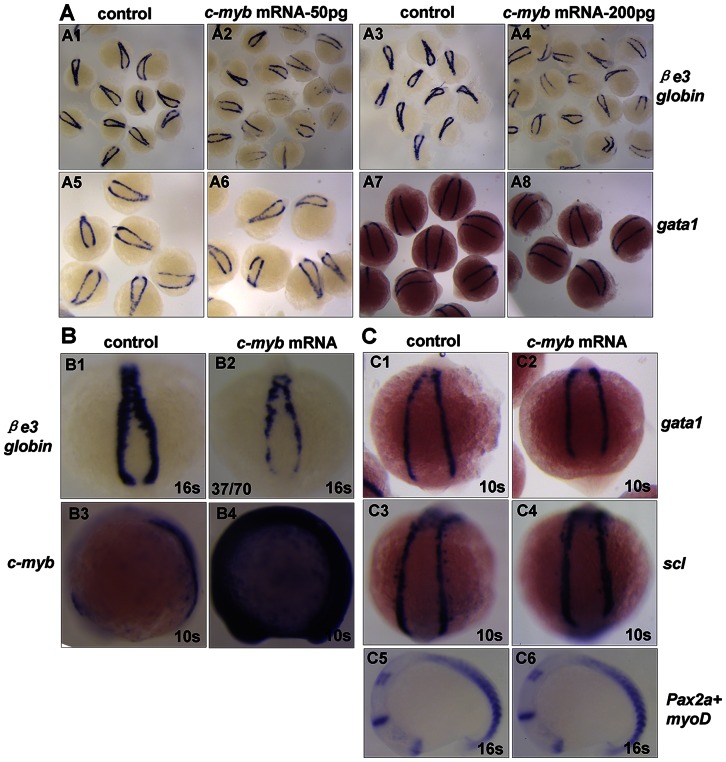

C-myb suppressed specification of mature erythroid cells, and the phenotype of c-myb gain of function is specific.(A) Different dosage of c-myb on specification of mature erythroid cells (βe3 globin: A2, 50 pg per embryo; A4, 200 pg per embryo) and on erythroid progenitors (gata1: A6, A8). (B) In situ hybridization of βe3 globin showed that erythroid differentiation was blocked in embryos with ectopic c-myb expression (50 pg per embryo) (B2), the number of embryos displayed reduced βe3 globin was shown in (B2), and the in situ hybridization of c-myb shown its ectopic expression in corresponding embryos (B4). (B) Hematopoietic progenitor cells including gata1 (C1, C2) and scl (C3, C4), and other mesoderm cells including pax2a and myoD (C5, C6) specified and maintained normally in embryos with ectopic c-myb expression. A1–A8, B1, B2, C1–C4, dorsal view, anterior to the up; B3, B4, C5, C6, lateral view, anterior to the left.